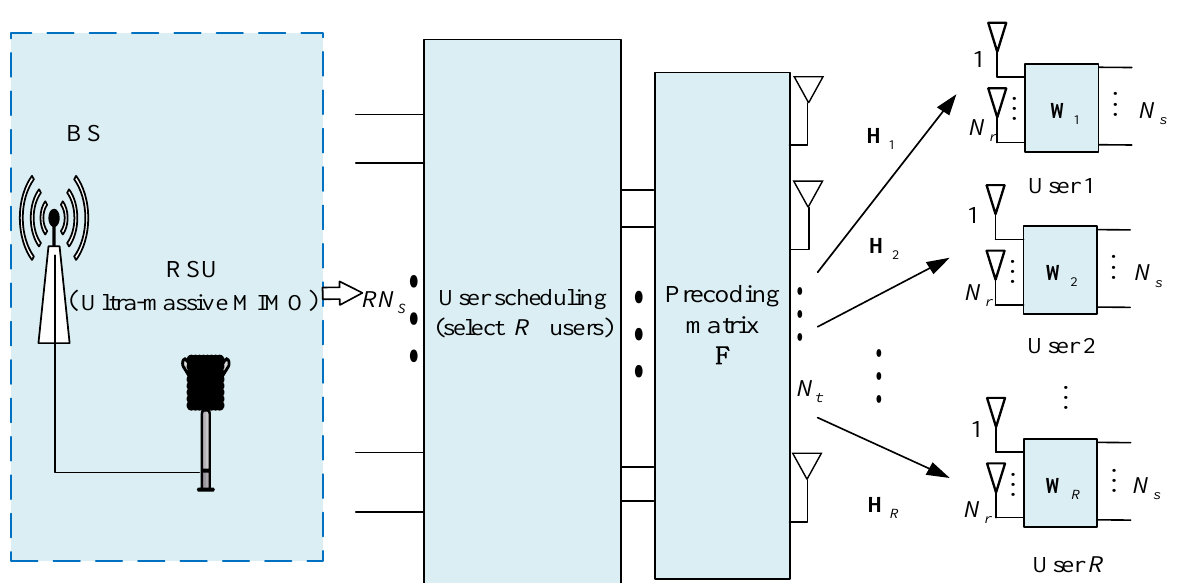
Figure 2. Multi-user scheduling for ultra-massive MIMO systems.